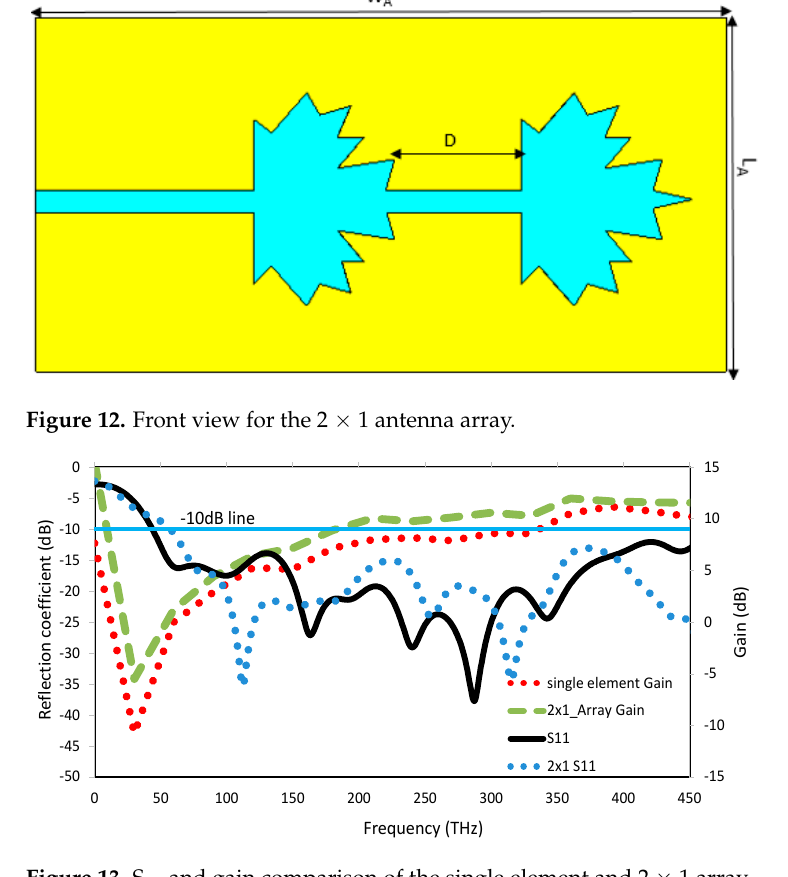
Figure 15. Radiation efficiency for the 2 × 1 antenna array.